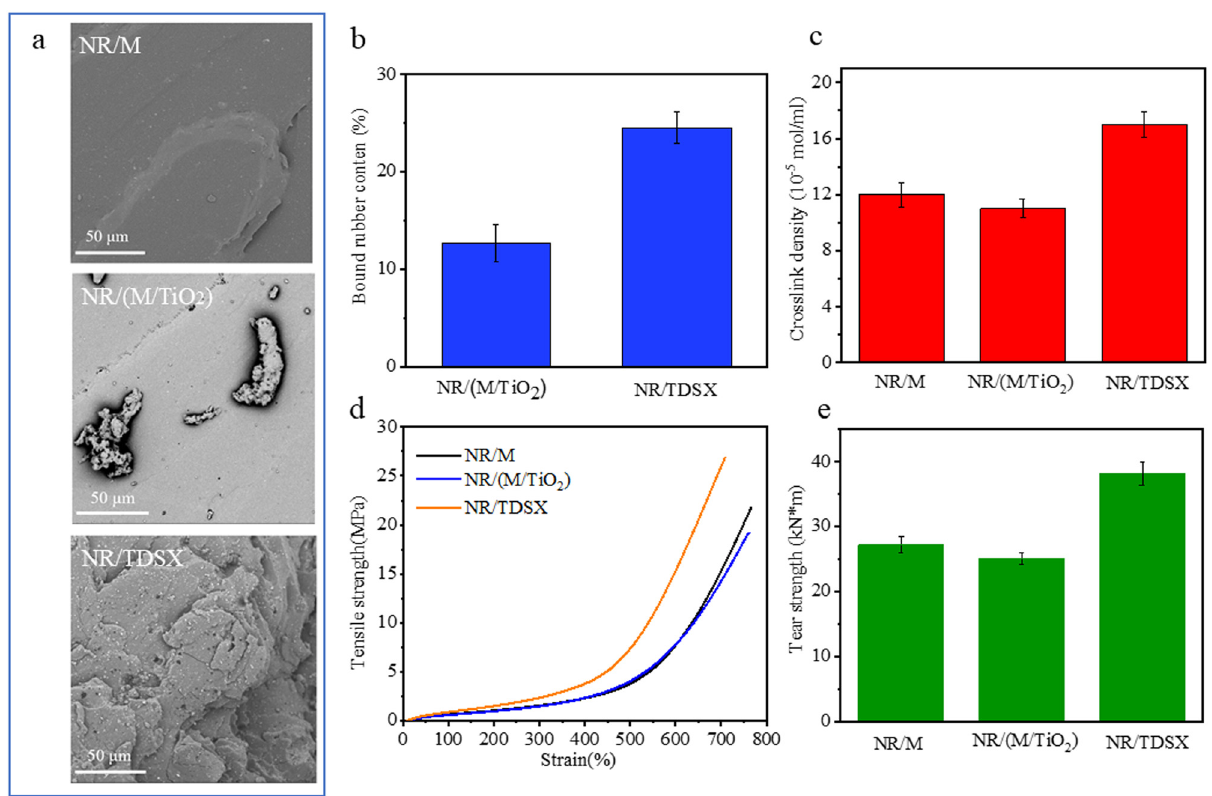
Figure 4: ( a ) SEM images for various samples; ( b ) the bound rubber content; ( c ) crosslink density; ( d ) curves of stress – strain; and ( e ) tear